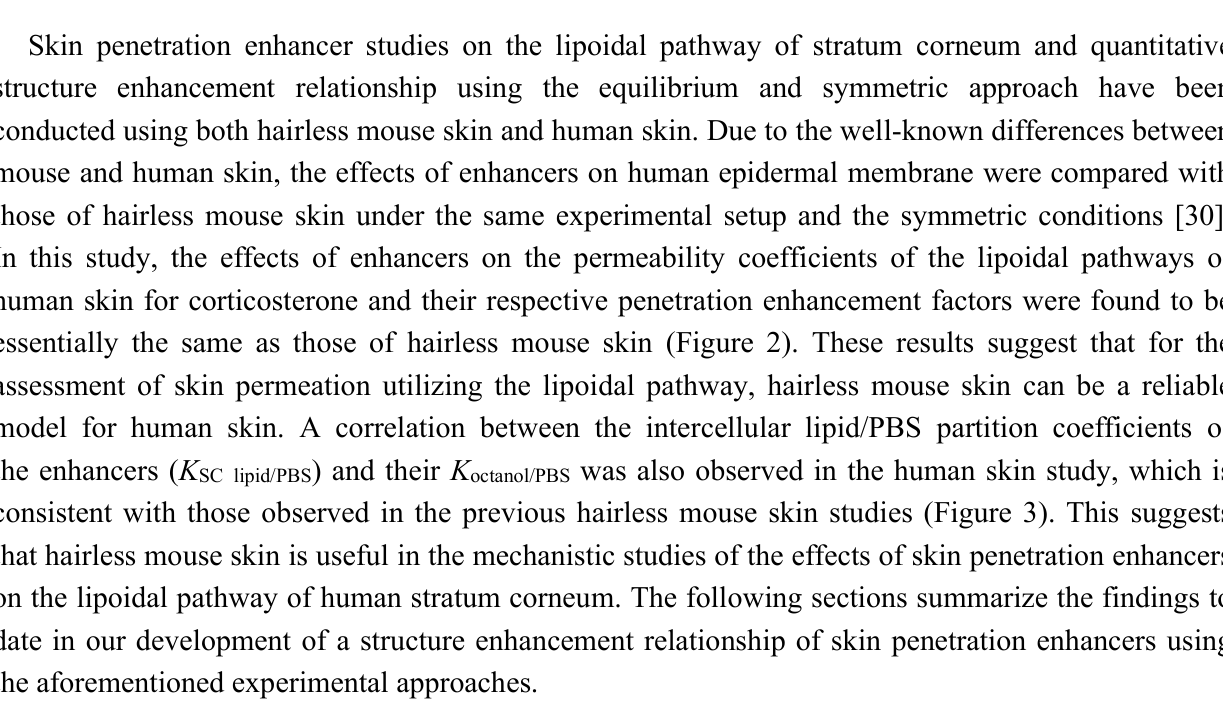
Figure 2. Representative results in the hairless mouse skin (HMS) and human epidermal membrane (HEM) studies. Isoenhancement concentrations (mM) of E = 10 obtained with HMS and HEM for the enhancers in phosphate buffered saline (PBS). Isoenhancement concentrations are defined as the aqueous concentrations for which different enhancers induce the same extent of penetration enhancement, E , for transport across the lipoidal pathway of stratum corneum. The data are taken from Chantasart et al .